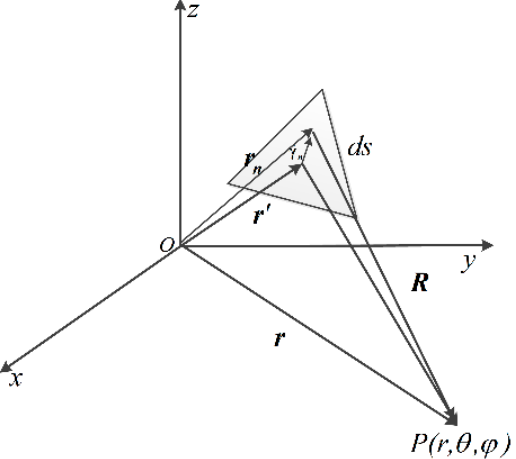
Figure 1. Schematic diagram of the facet and expansion center.